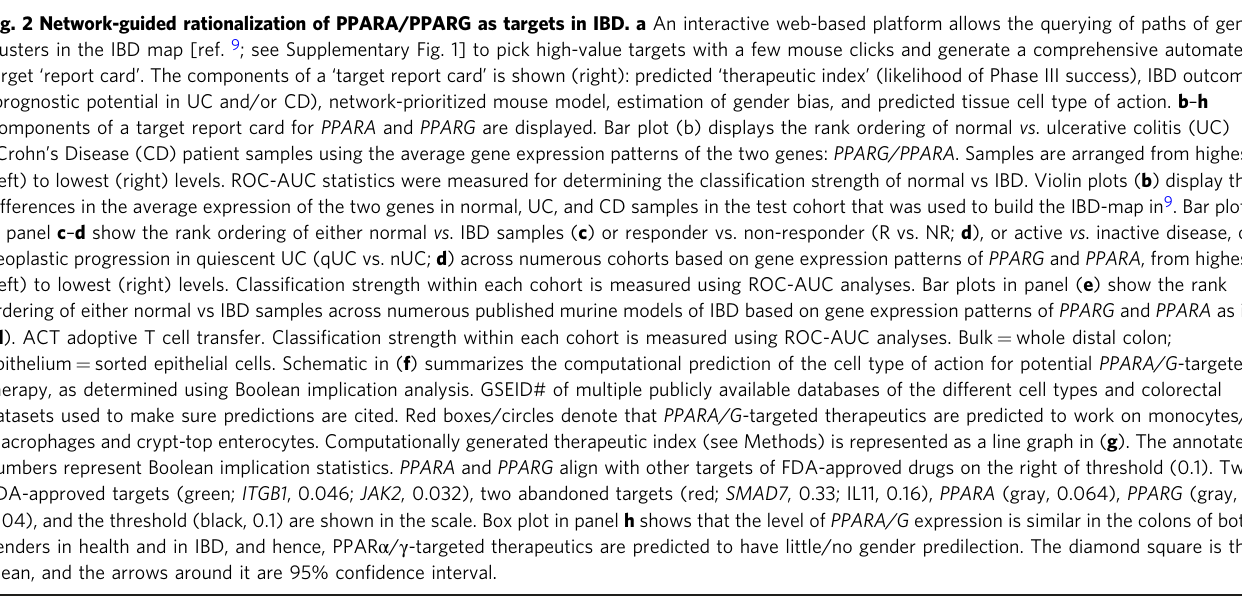
Fig. 2 Network-guided rationalization of PPARA/PPARG as targets in IBD. a An interactive web-based platform allows the querying of paths of gene clusters in the IBD map [ref. 9 ; see Supplementary Fig. 1] to pick high-value targets with a few mouse clicks and generate a comprehensive automated target ‘ report card ’ . The components of a ‘ target report card ’ is shown (right): predicted ‘ therapeutic index ’ (likelihood of Phase III success), IBD outcome (prognostic potential in UC and/or CD), network-prioritized mouse model, estimation of gender bias, and predicted tissue cell type of action. b – h Components of a target report card for PPARA and PPARG are displayed. Bar plot (b) displays the rank ordering of normal vs . ulcerative colitis (UC) /Crohn ’ s Disease (CD) patient samples using the average gene expression patterns of the two genes: PPARG/PPARA . Samples are arranged from highest (left) to lowest (right) levels. ROC-AUC statistics were measured for determining the classi fi cation strength of normal vs IBD. Violin plots ( b ) display the differences in the average expression of the two genes in normal, UC, and CD samples in the test cohort that was used to build the IBD-map in 9 . Bar plots in panel c – d show the rank ordering of either normal vs . IBD samples ( c ) or responder vs. non-responder (R vs. NR; d ), or active vs . inactive disease, or neoplastic progression in quiescent UC (qUC vs. nUC; d ) across numerous cohorts based on gene expression patterns of PPARG and PPARA , from highest (left) to lowest (right) levels. Classi fi cation strength within each cohort is measured using ROC-AUC analyses. Bar plots in panel ( e ) show the rank ordering of either normal vs IBD samples across numerous published murine models of IBD based on gene expression patterns of PPARG and PPARA as in ( d ). ACT adoptive T cell transfer. Classi fi cation strength within each cohort is measured using ROC-AUC analyses. Bulk = whole distal colon; epithelium = sorted epithelial cells. Schematic in ( f ) summarizes the computational prediction of the cell type of action for potential PPARA/G -targeted therapy, as determined using Boolean implication analysis. GSEID# of multiple publicly available databases of the different cell types and colorectal datasets used to make sure predictions are cited. Red boxes/circles denote that PPARA/G -targeted therapeutics are predicted to work on monocytes/ macrophages and crypt-top enterocytes. Computationally generated therapeutic index (see Methods) is represented as a line graph in ( g ). The annotated numbers represent Boolean implication statistics. PPARA and PPARG align with other targets of FDA-approved drugs on the right of threshold (0.1). Two FDA-approved targets (green; ITGB1 , 0.046; JAK2 , 0.032), two abandoned targets (red; SMAD7 , 0.33; IL11, 0.16), PPARA (gray, 0.064), PPARG (gray, 0.04), and the threshold (black, 0.1) are shown in the scale. Box plot in panel h shows that the level of PPARA/G expression is similar in the colons of both genders in health and in IBD, and hence, PPAR α / γ -targeted therapeutics are predicted to have little/no gender predilection. The diamond square is the mean, and the arrows around it are 95% con fi dence